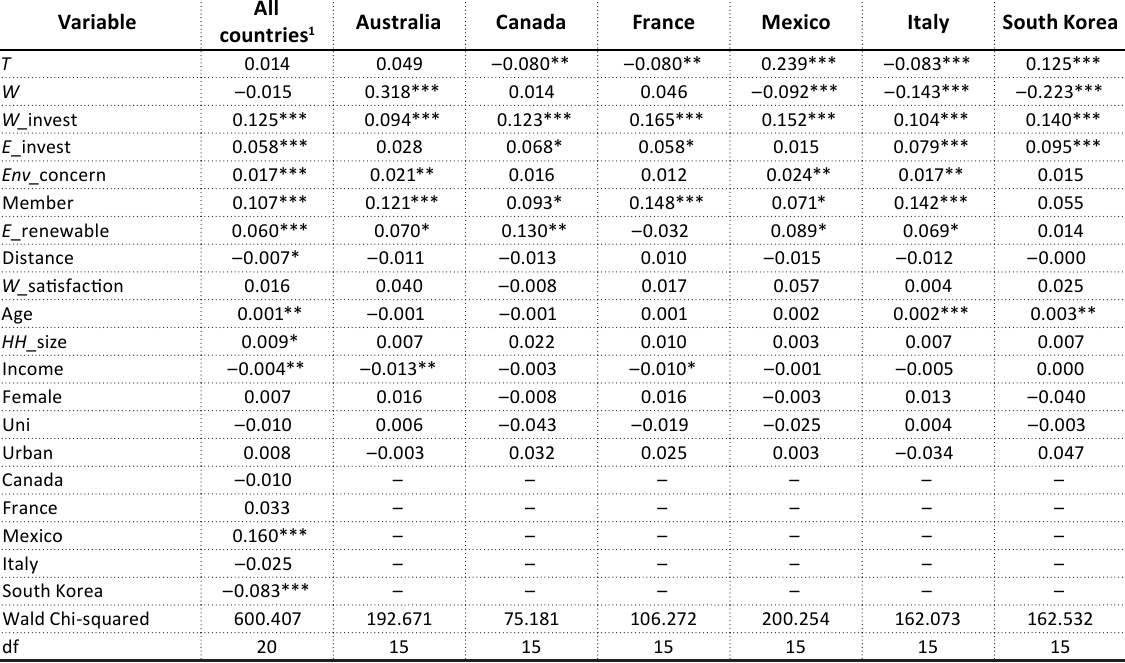
Table Bl. Average discrete effects of binary probit, dependent variable in model: engagement in pro- environmental acitivities above the median, base domain: energy